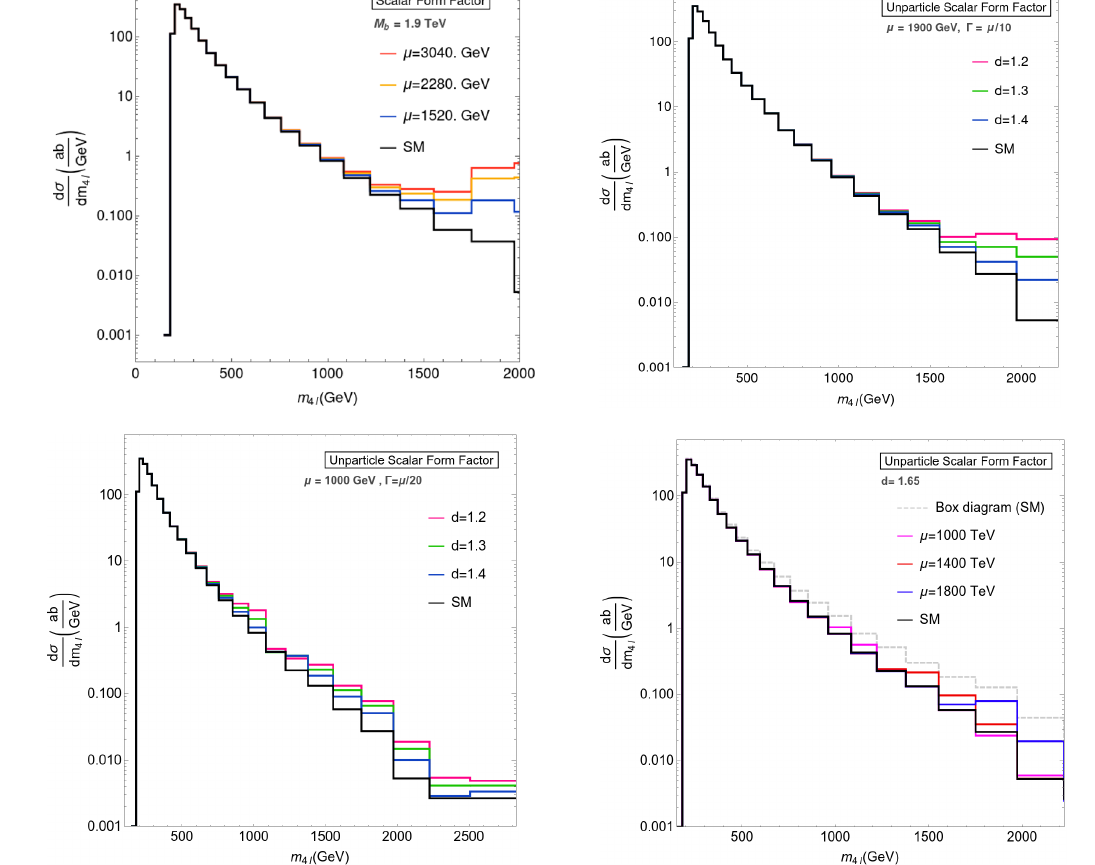
Figure 13 . Differential cross section as a function of the final 4 l state invariant mass for the different form factor models of section 4. The top left figure shows the scalar resonance form factor for the different values of the scalar mixing coupling µ . We assume a scalar width of 10% of the scalar mass. The top right and bottom left figures display the unparticle scalar form factor for a 10% and a 20% widths respectively. The values of the anomalous dimension d < 1 . 6 correspond to an enhancement of the coupling below at low energies. In the bottom right figure we show the unparticle case for d = 1 . 65 , when the form factor induces a suppression of the Higgs coupling. We note that even for a suppressed Higgs coupling, it is still possible to get an enhanced signal with respect to the